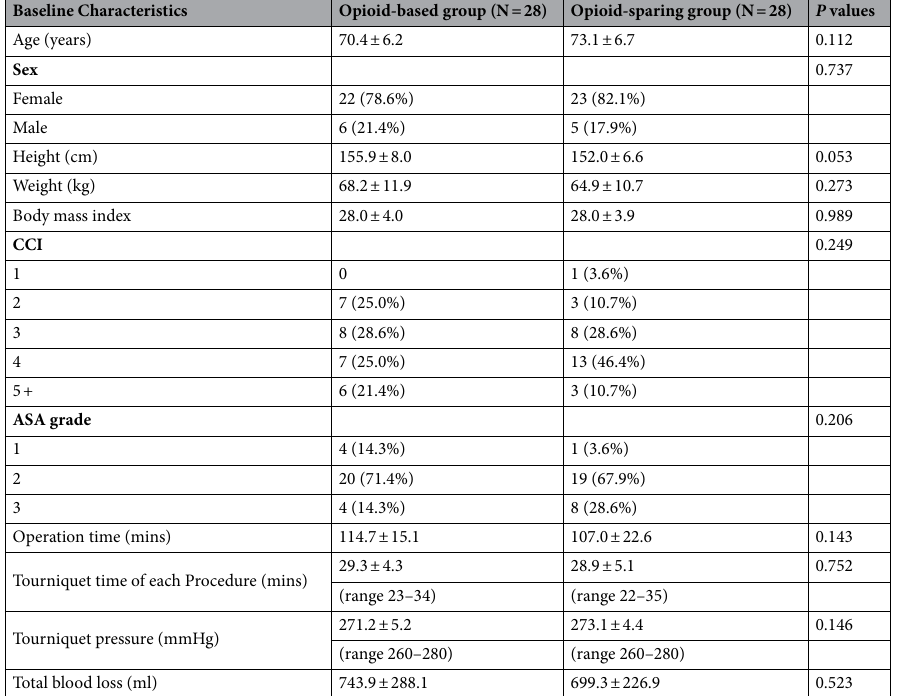
Table 1. Patient demographics. ASA: American Society of Anesthesiologists; CCI: Charlson comorbidity index.